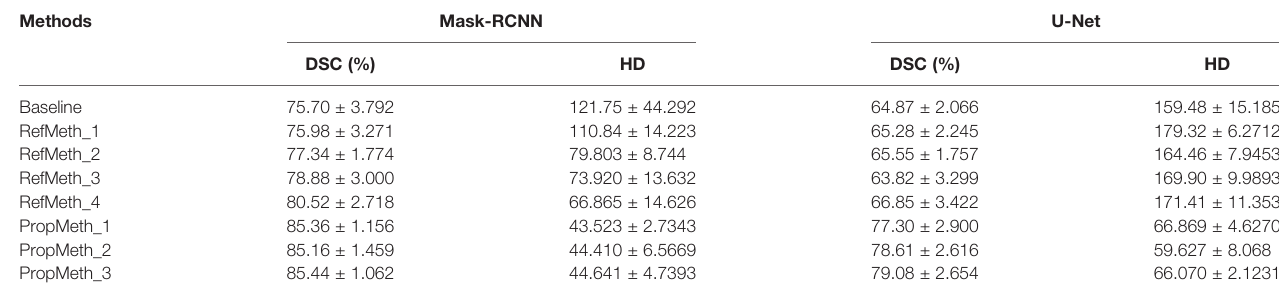
TABLE 3 | Segmentation performance evaluation on Mask-RCNN and U-Net.